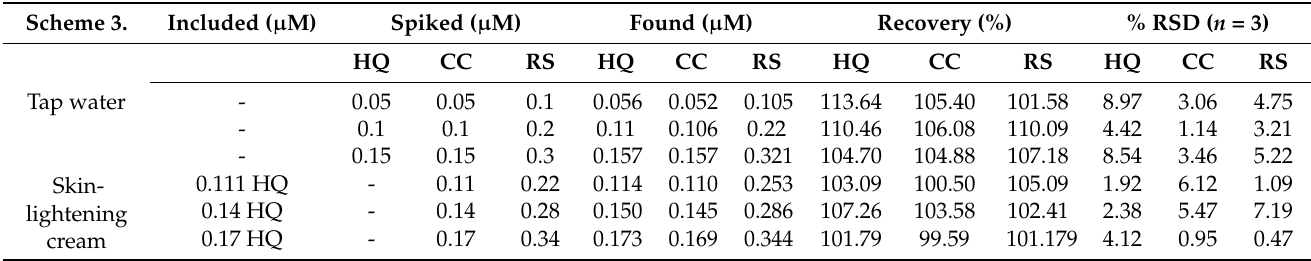
Table 3. Determination of HQ, CC, and RS in tap water and skin-lightening cream at the GCE/ErGO-cMWCNT/AuNPs ( n = 3). Scheme